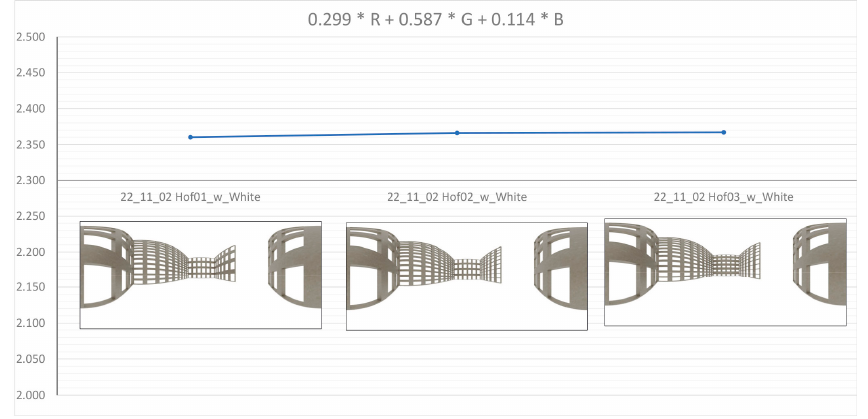
Figure 10. Measurement method “Grayscale DBX M × N ( m × m ) (shifting boxes)” with the grayscale conversion adapted to the perception of brightness (see Formula (13)) applied to portrait windows of the opposite and right façades ( left ; image “22_11_02 Hof01_w”; 𝐷 (cid:3003) = 2.360 ), lower windows on the right façade ( center ; image “22_11_02 Hof02_w”; 𝐷 (cid:3003) = 2.366 ), and additional smaller windows of the opposite façade ( right ; image “22_11_02 Hof03_w”; 𝐷 (cid:3003) = 2.367 ).